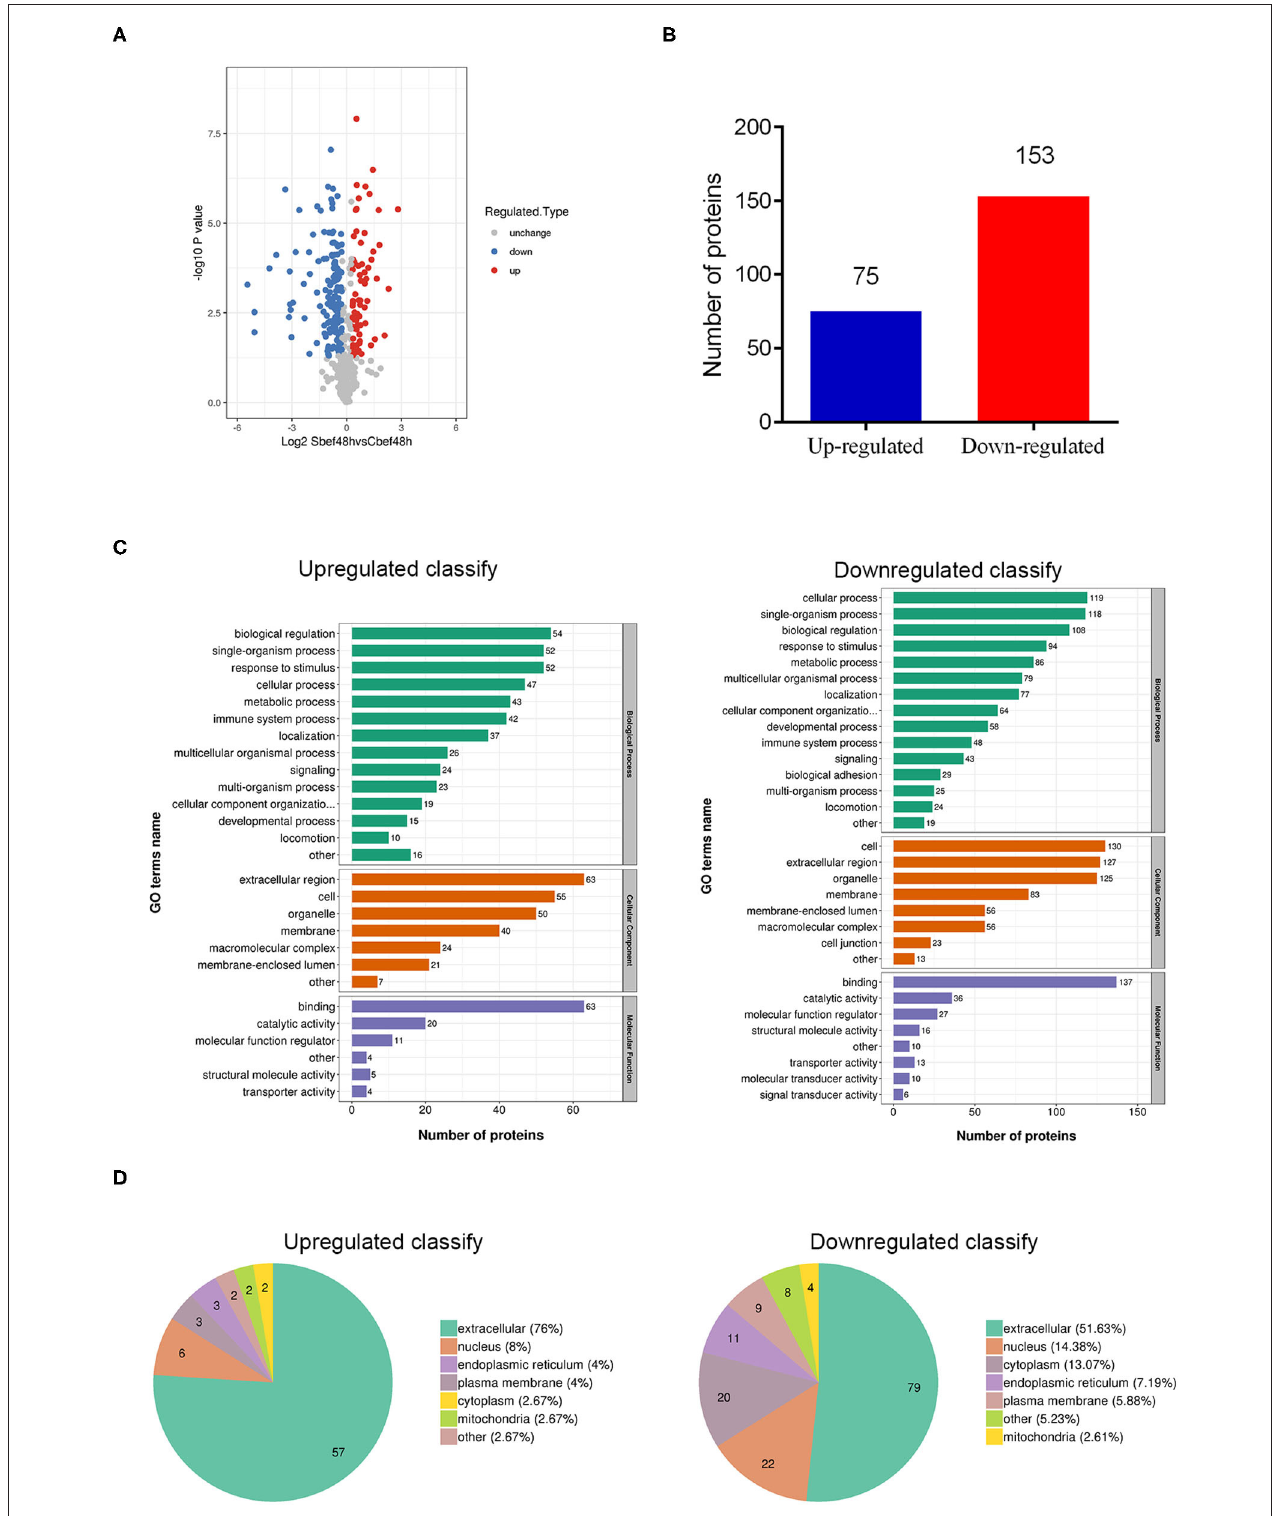
FIGURE 2 | Overview of differentially expressed proteins in human plasma delivered exosomes. (A) The hot map of differently expressed proteins in exosomes. (B) Number of up-regulated and down-regulated proteins. (C) Gene Ontology functional analysis of differently expressed proteins in exosomes (biological process, cellular component, and molecular function). (D) Subcellular localization analysis of differently expressed proteins in exosomes.